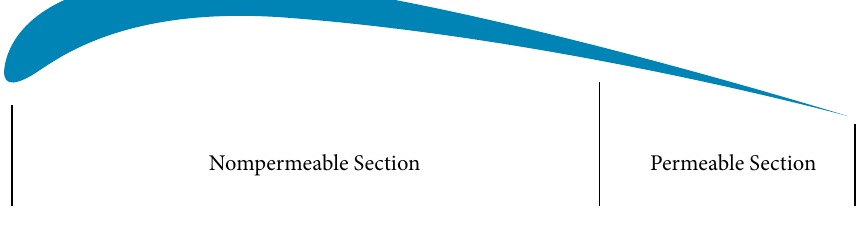
Figure 10. Eagle’s airfoil with permeable